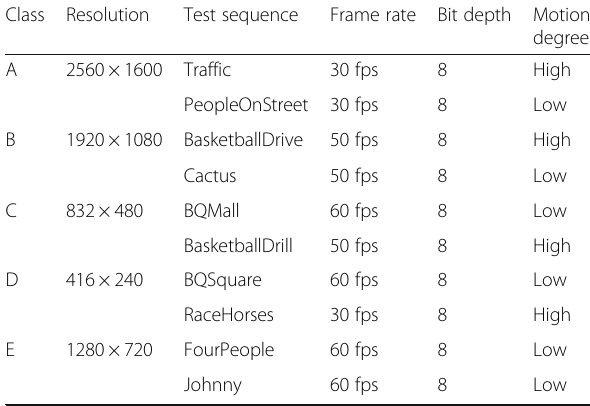
Table 1 Test sequence